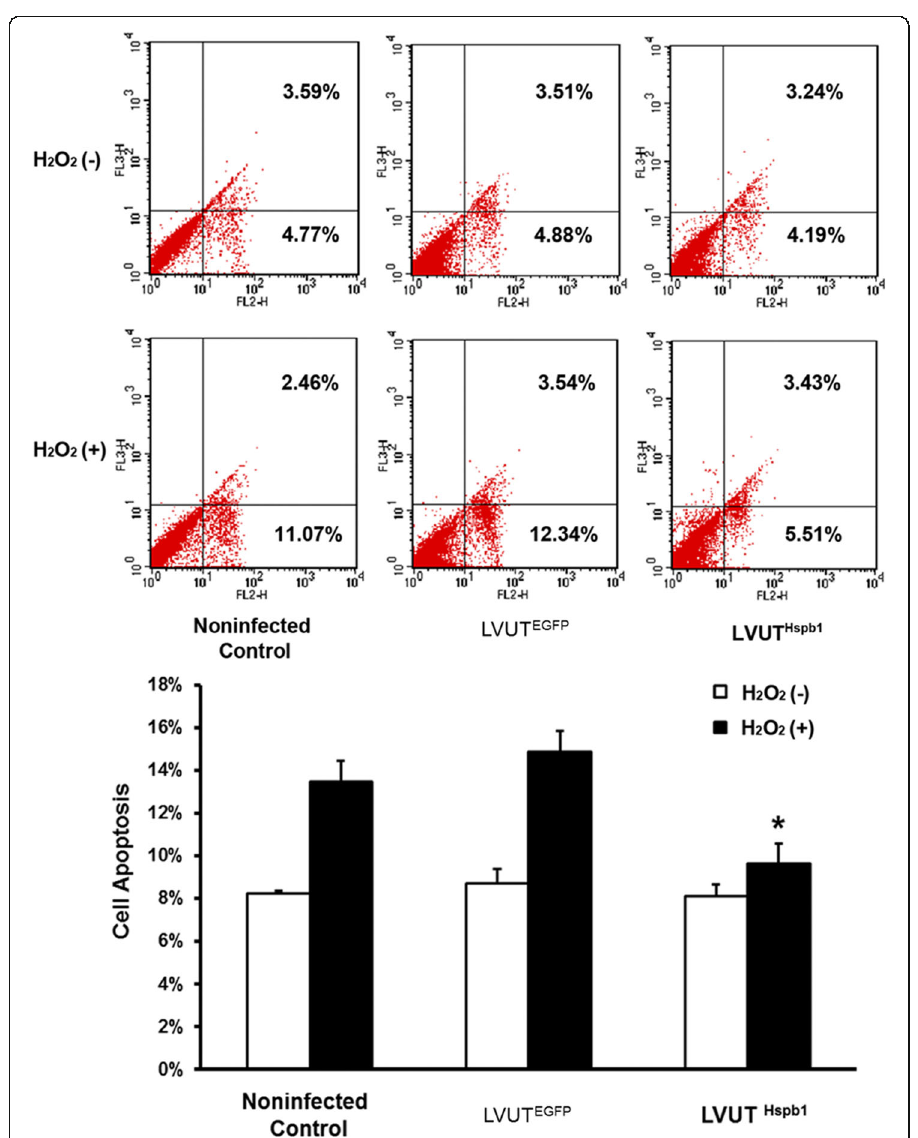
indicates a live cell population, the lower right quadrant indicates an early apoptotic cell population, and the upper right quadrant indicates a late apoptotic or dead cell population. H 2 O 2 -induced cell apoptosis was significantly attenuated in A10 cells infected with LVUT Hspb1 compared with A10 cells infected with LVUT EGFP (*p < 0.001). The rate of apoptosis showed no significant difference between the non-infected control and LVUT EGFP (n =